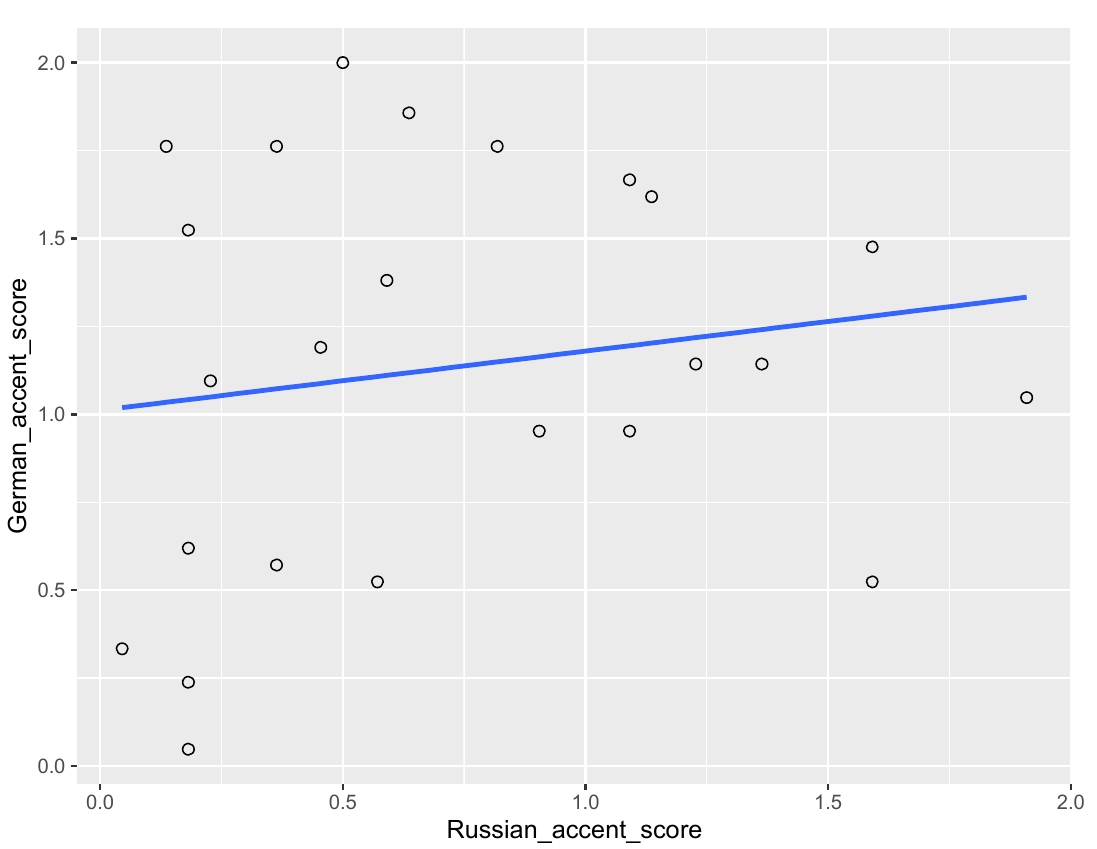
Figure 3. Mean accent score in German by mean accent score in Russian.